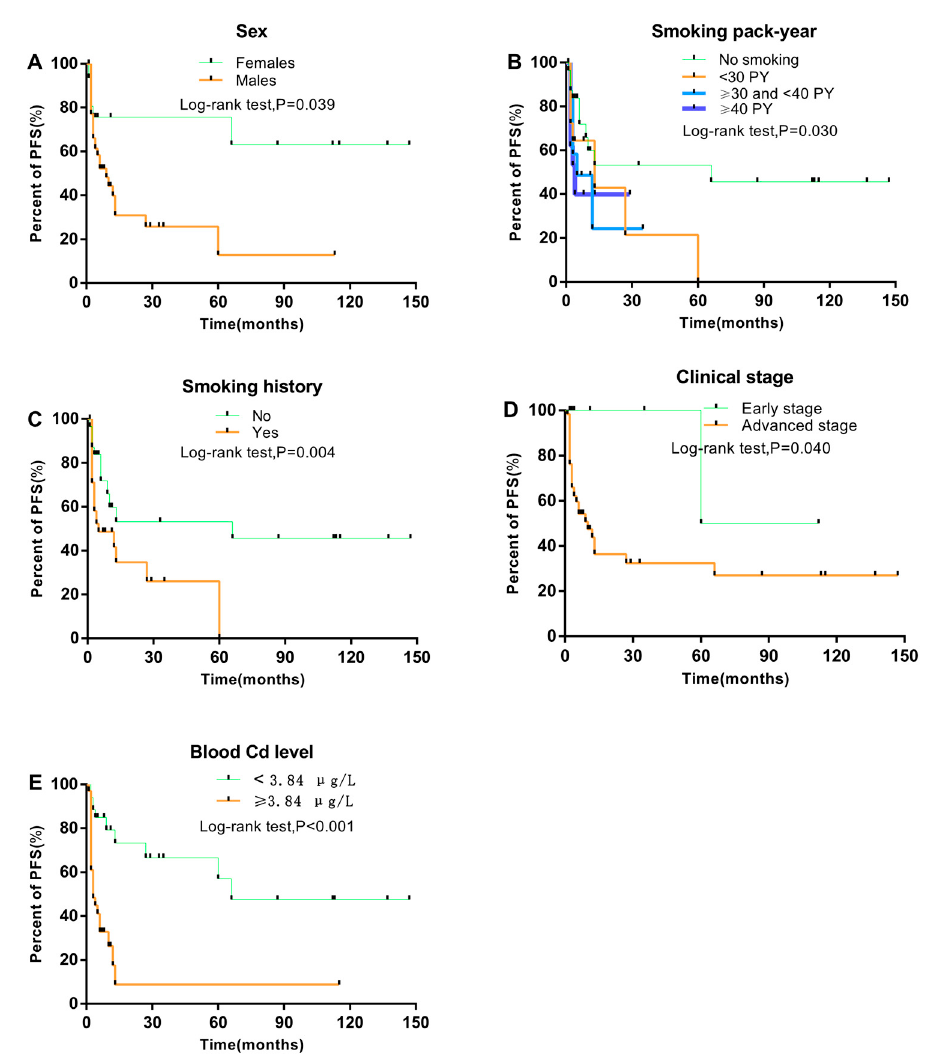
Figure 1. Comparison of PFS among different groups of NPC patients by Kaplan–Meier log-rank test. ( A – E ) PFS by sex, smoking pack-years, smoking history, clinical stage, and blood Cd level, respectively (n = 134).